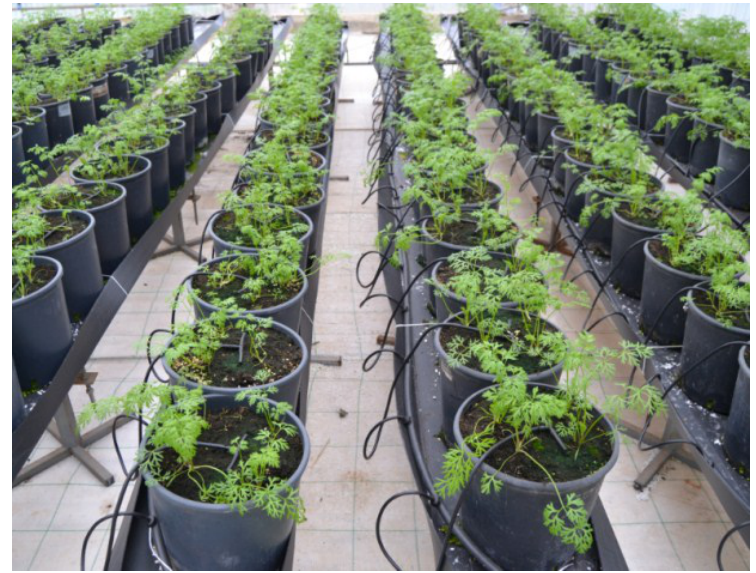
Figure 17. Catalog field of Polignano carrot realized by using soilless systems within the greenhouse of the “La Noria” experimental farm—National Research Council, Bari, Italy.